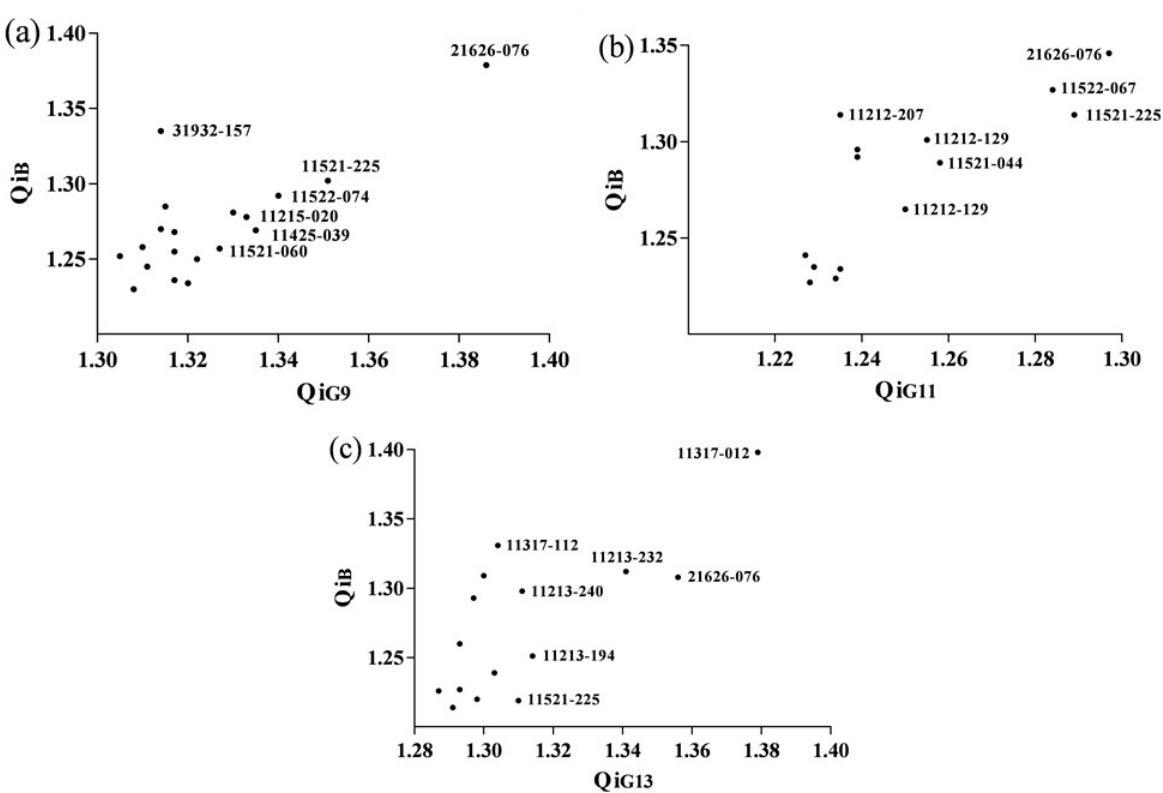
Figure 5. Qi values of 200 C. fargesii clones based on growth traits by comprehensive evaluation methods. Q iB , Comprehensive evaluation index of breeding value of tree height and diameter. Q i G9 ( a ), Q i G11 ( b ) and Q iG11 ( c ) represent the comprehensive evaluation indexes of height and DBH of 9-, 11- and 13-year-old trees, respectively.